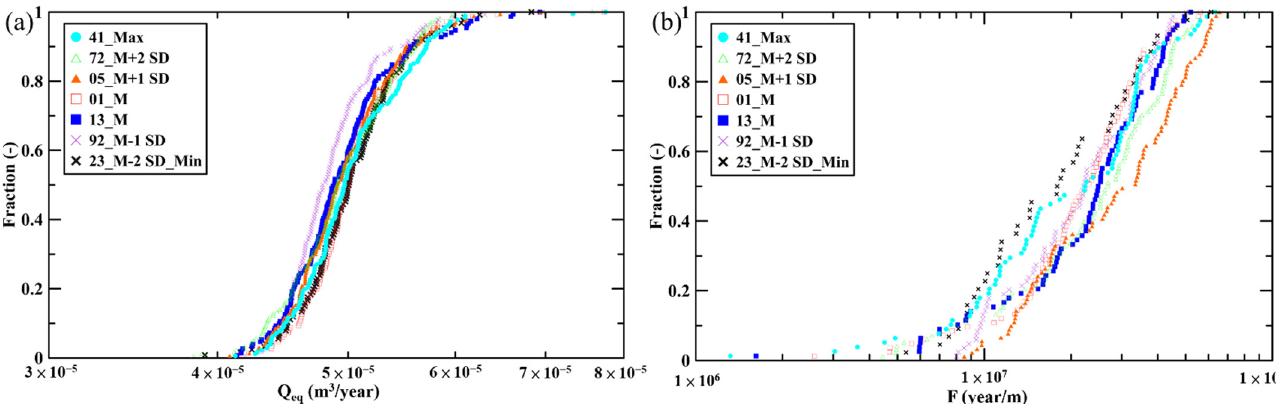
Figure 14. Q eq and F of the realizations relative to the statistical results of the remaining number of DHs after involving the rejection criteria for the Q1 path. ( a ) The results of Q eq for the statistical results of the remaining number of DHs after involving the rejection criteria; ( b ) The results of F for the statistical results of the remaining number of DHs after involving the rejection criteria.